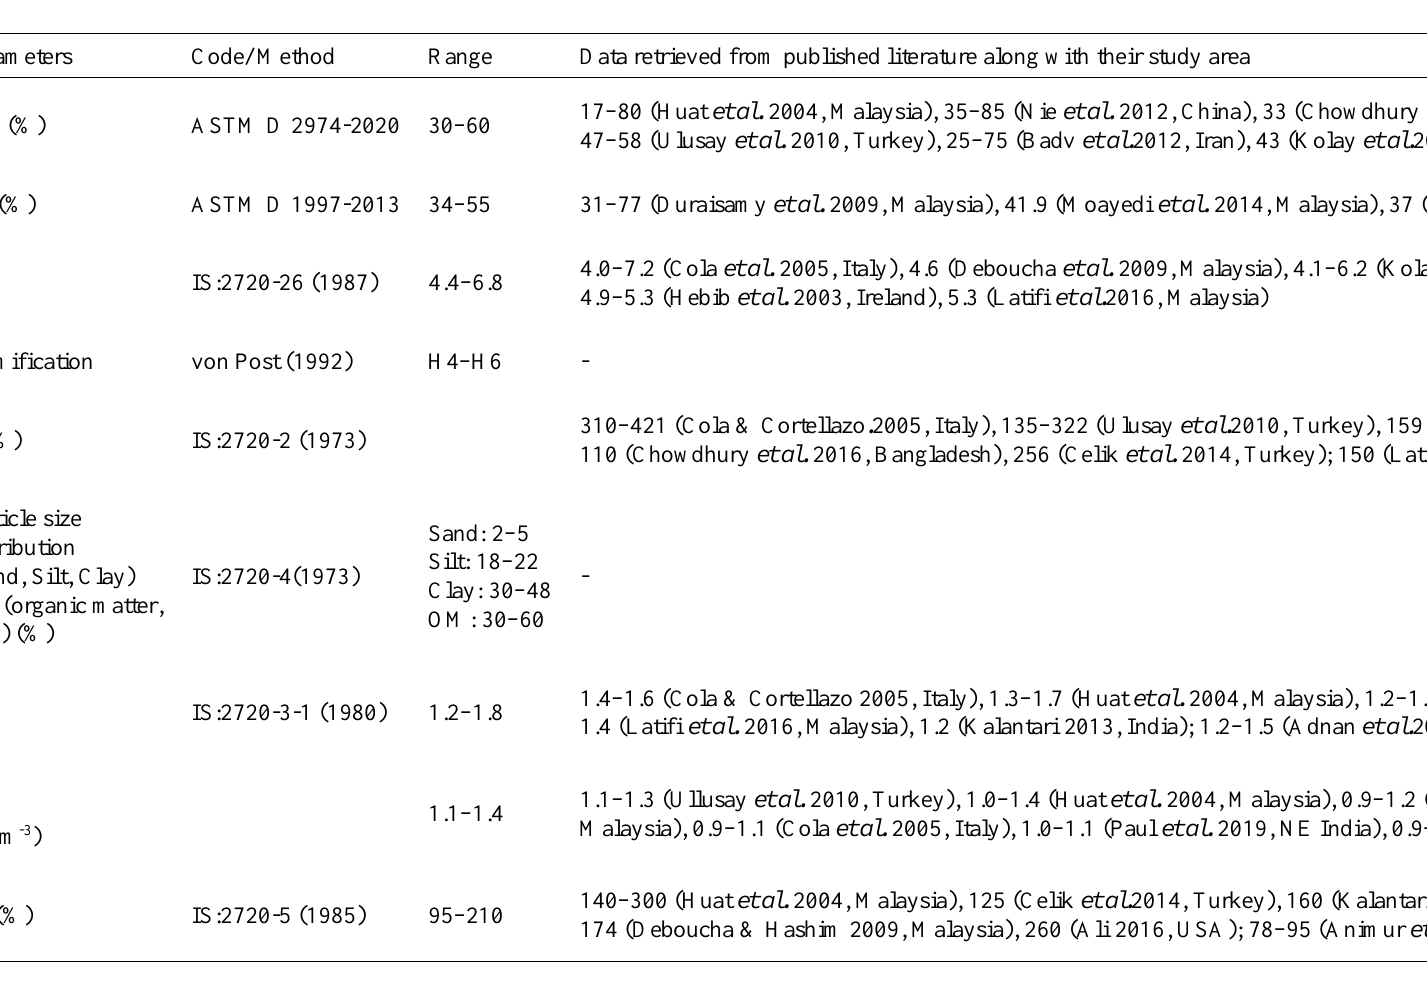
Table A1. Physiochemical properties of peat samples. OM = organic matter, FC = fibre content, pH = potential of hydrogen, w = water content, G p = specific gravity, γ b = bulk density, LL = liquid